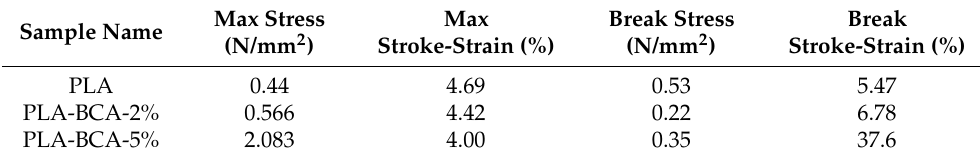
Table 2. Mechanical properties of electrospun PLA fibers with and without biochanin A.